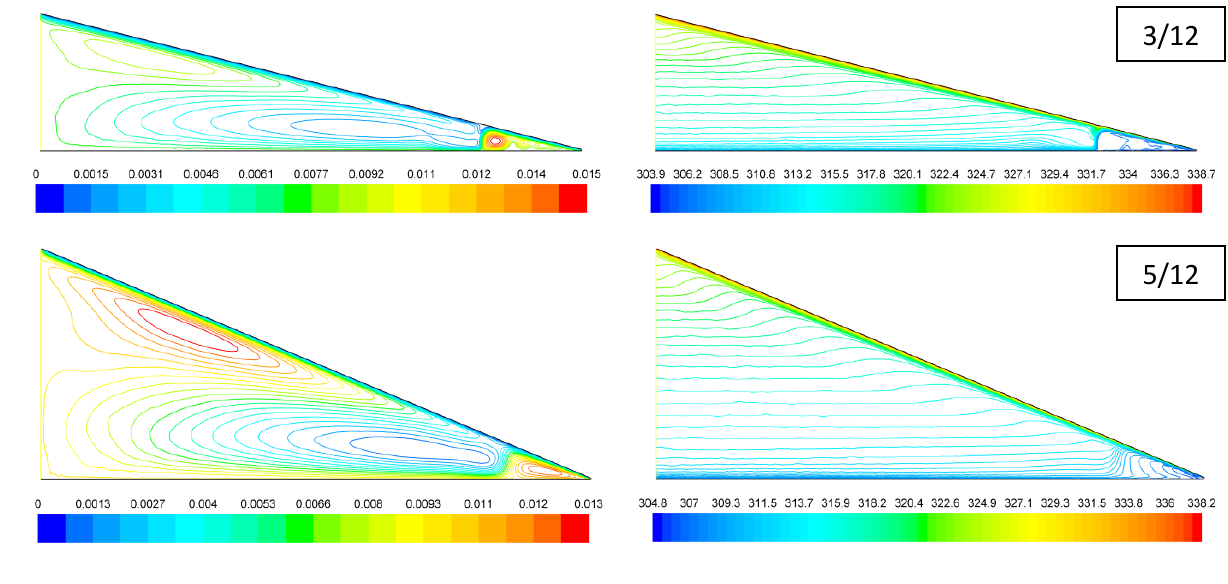
Figure 5. Predicted ( left ) streamlines (in kg/m·s) and ( right ) isotherms (in K) for attics with R-20 ceiling